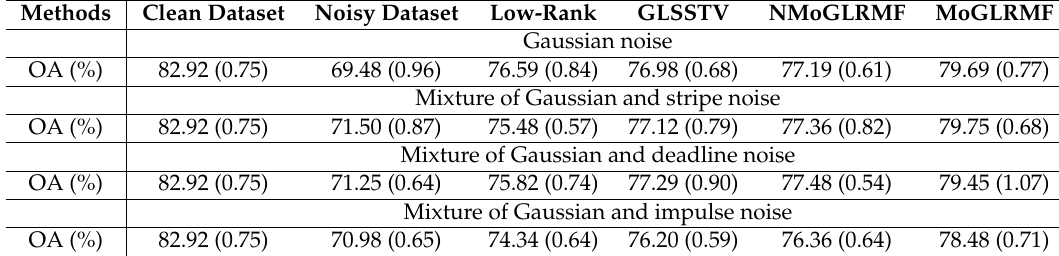
Table 4. Overall accuracy (OA) of different methods on the synthetic